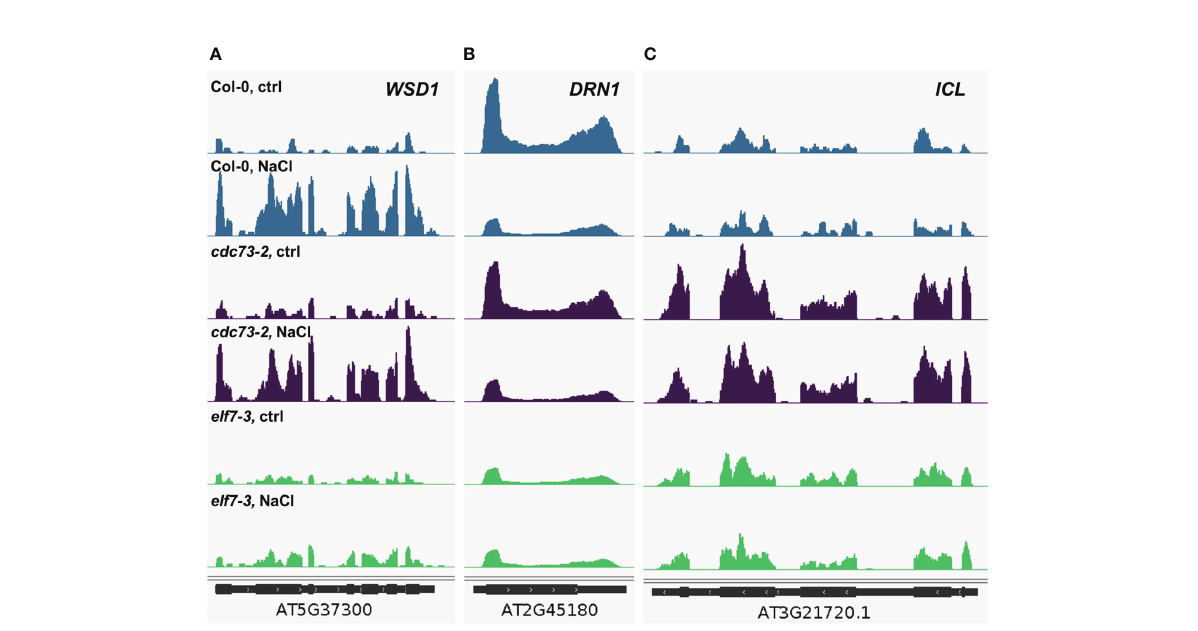
FIGURE 5 Changes in transcript levels in the different genotypes at individual loci dependent on the presence of NaCl. Coverage of merged RNA-seq samples was normalised to the effective Arabidopsis genome size and visualised using the Integrative Genomics Viewer. (A) coverage of WSD1 (At5g37300), a gene induced by elevated salt concentrations. (B) coverage of DRN1 (At2g45180), a gene repressed by elevated salt concentrations. (C) coverage of ICL (At3g21720), a gene, whose expression enhances salt